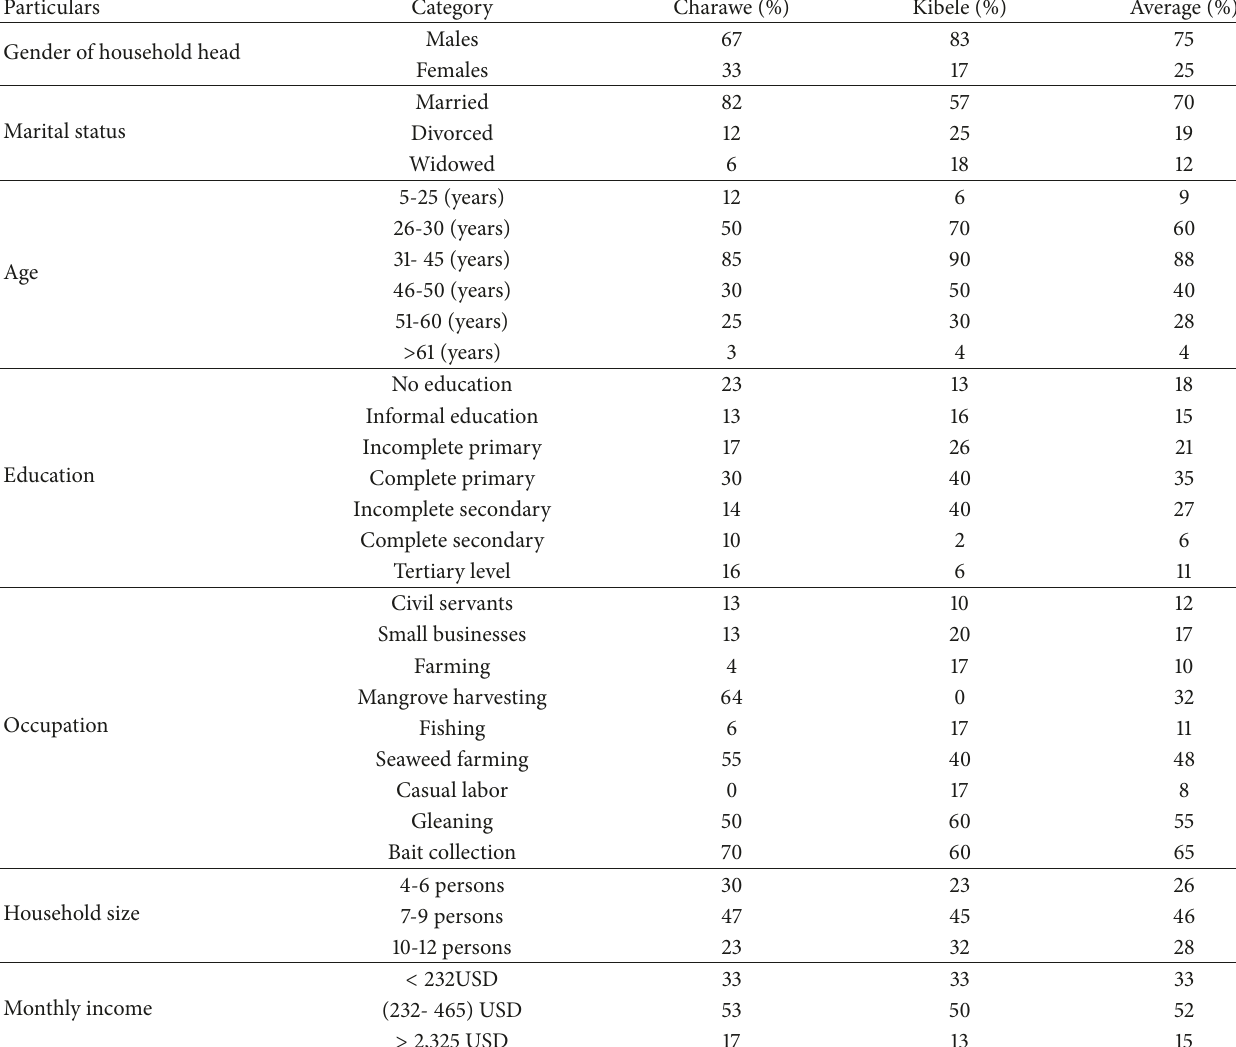
Table 1: Socioeconomic characteristics of households in the study sites (n =